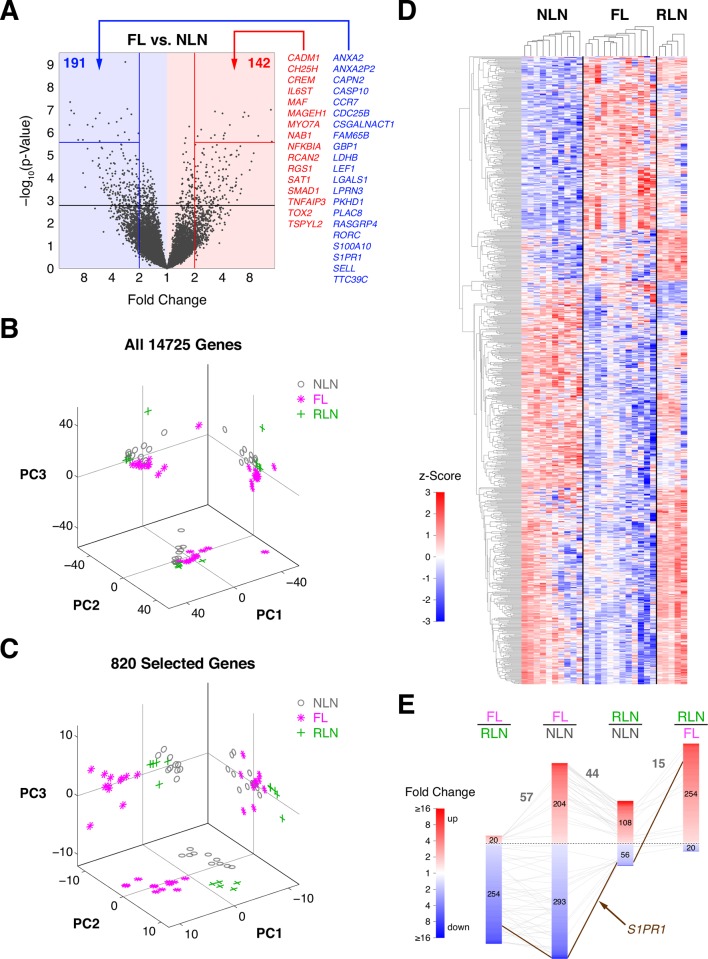
Significant genes between groups and feature selection.A. Volcano plot for FL vs. NLN comparison. -log10 p-value is plotted against the fold change (log2 scale). Black horizontal line corresponds to an FDR of 0.05. 37 genes with a FDR < 0.001 (horizontal red and blue lines) and a greater than two-fold change in either direction are labeled. Red and blue numbers indicate number of genes with FDR < 0.05 and a two-fold change. See Supplemental Fig 2 for similar plots of RLN vs. NLN and RLN vs. FL. B. Distribution of 27 samples over the first three principal components (PCs). PCs were computed using log10-transformed RPM to reduce the dimensionality. PCs were based on all 14725 genes. Shadows of three-dimensional data are shown on the three coordinate planes. C. PCs computed considering only 820 selected genes. These genes were significant for at least one pairwise comparison (FL vs. NLN, n = 497; RLN vs. FL, n = 274; RLN vs. NLN, n = 164). D. Heat map of clustered, significant genes as described in C. Rows are genes, columns are samples, and color maps to a gene’s z-score based on log-transformed data (computed independently for each gene). Samples are organized by histology but are clustered within their group. Euclidean distance and average linkage were used for clustering. E. Comparison of three statistical gene lists. Each bar represents a comparison with their constituent genes ranked according to fold change (color) and with the number of up- and down-regulated genes shown in the red and blue portions, respectively. Lines connecting bars represent genes shared between lists. (RL vs. FL is shown twice but with different polarities). Only one gene, S1PR1 appeared in all three lists (highlighted in brown).